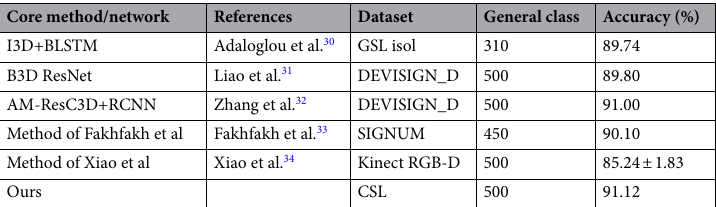
Table 7. Comparative experimental results of different